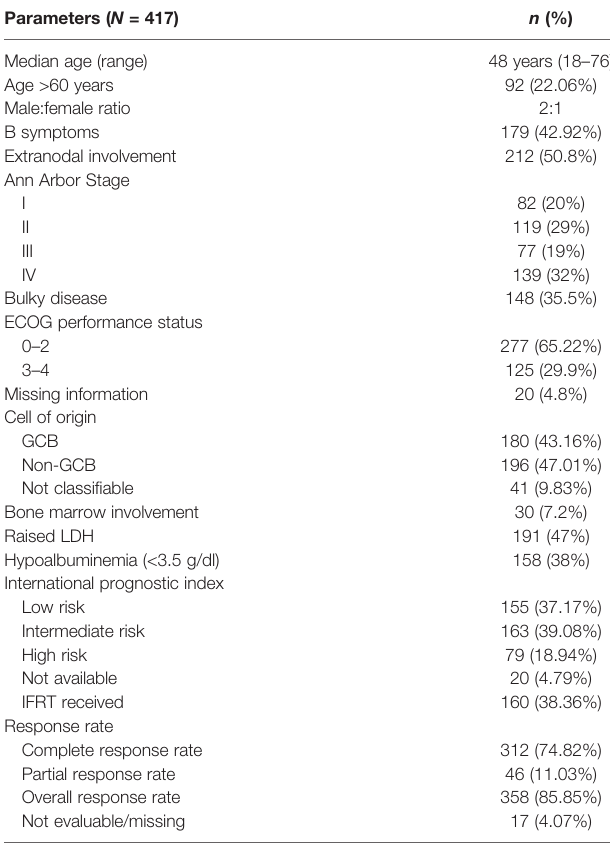
TABLE 1 | Baseline characteristics of 417 diffuse large B-cell lymphoma